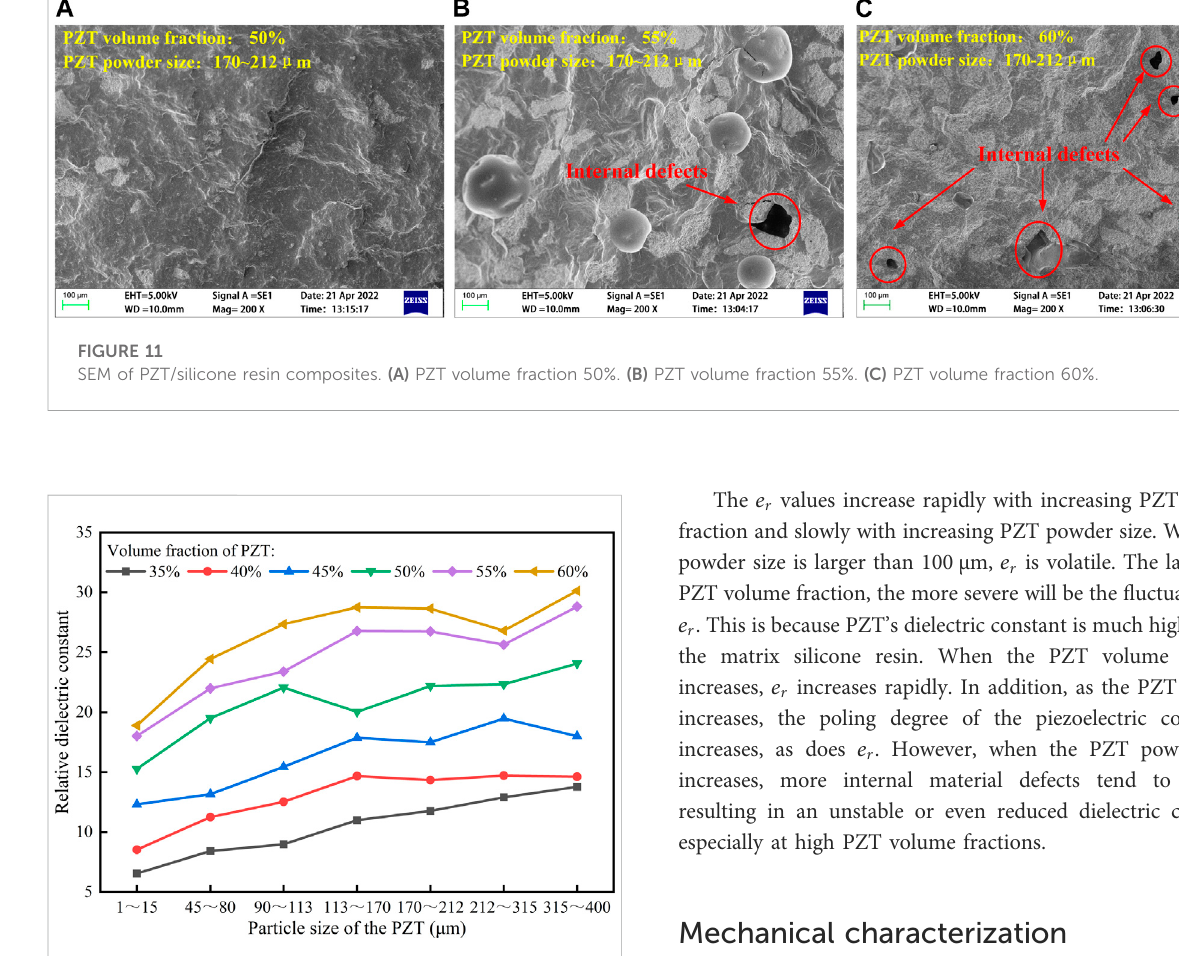
FIGURE 12 Variation of the composite relative dielectric constant with PZT volume fraction and powder